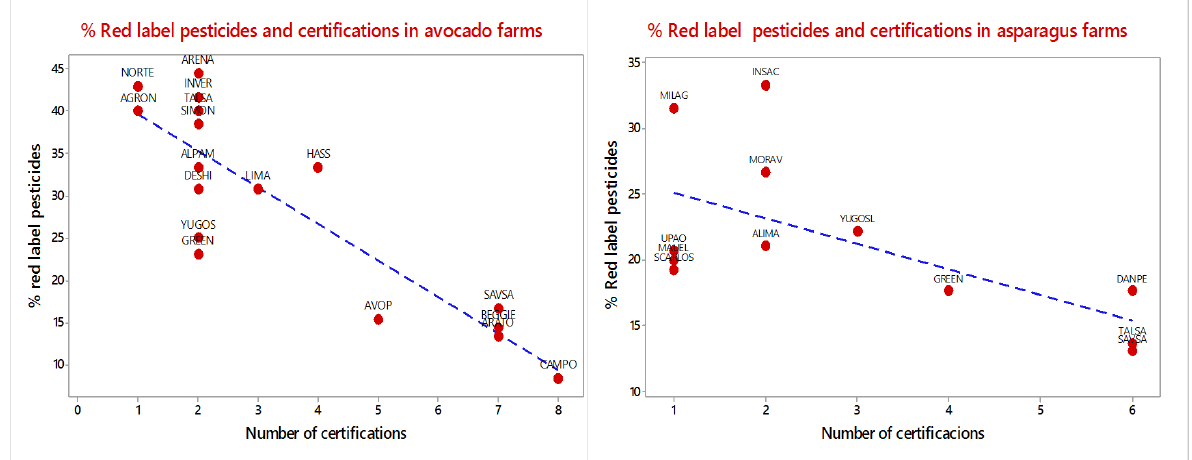
Figure 9. Relationship between the percentage of red label pesticides and number of certifications used in asparagus and avocado farms of the Chavimochic irrigation project in